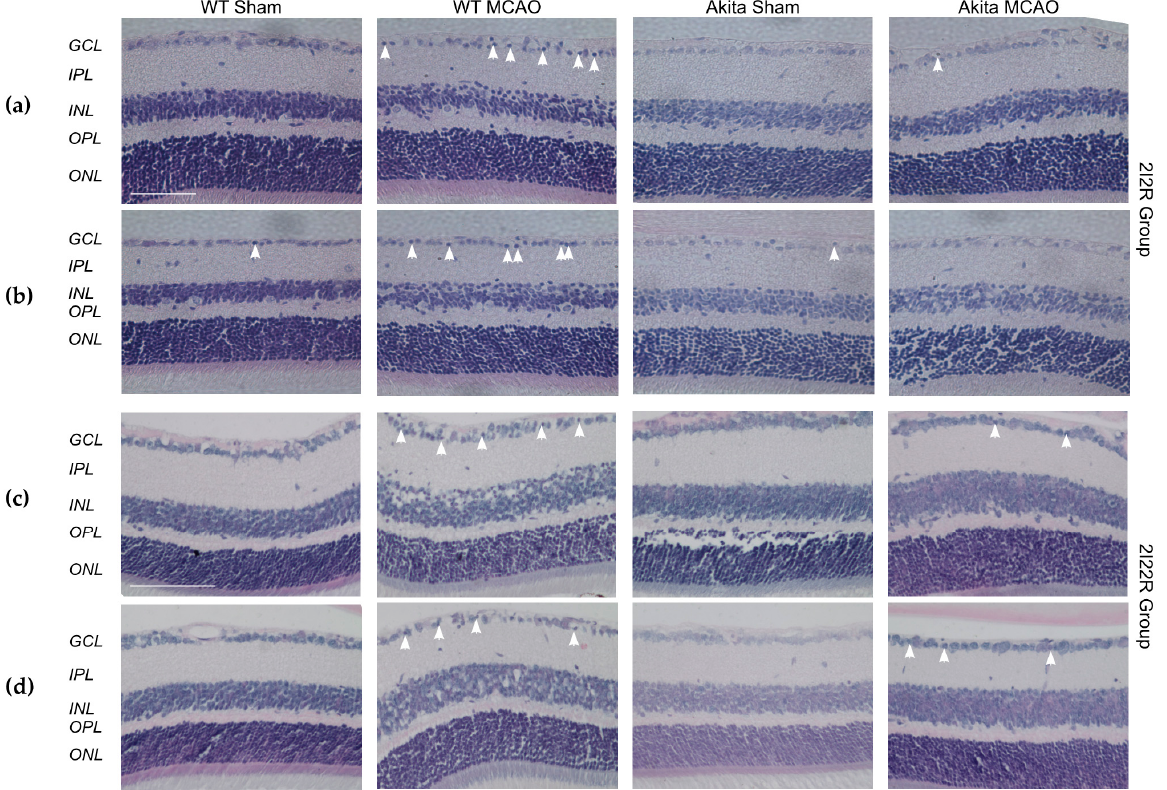
Figure 2. Retinal morphological samples from the 2I2R and 2I22R group in the central retina ( a , c ) and mid-peripheral retina ( b , d ). Morphological examination under 40 × magnification ( a , b ) and 20 × magnification ( c , d ) showed similar retinal thicknesses in all layers among all groups in both the central and mid-peripheral retinae. More pyknotic cells were observed in the WT MCAO-injured retinae (arrowheads) as compared with WT sham-treated retinae in the 2I2R group, and in the MCAO-injured retinae (arrowheads) as compared with sham-treated retinae in the 2I22R group. There is a slight increase in total retinal thickness in MCAO-injured retinae as compared to sham-treated retinae in the 2I22R group. Scale bars: 50 μ m ( a , b ), 100 μ m ( c , d ). Figure and caption has been adapted from a dissertation [9] . Please refer to acknowledgements section. WT MCAO-injured retinae showed a higher ratio of cells with pyknotic nuclei to